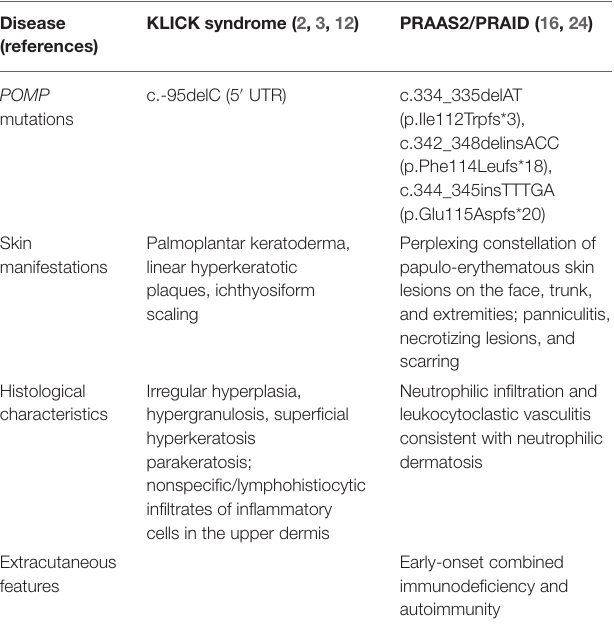
TABLE 1 | Comparison of two syndromes associated with POMP